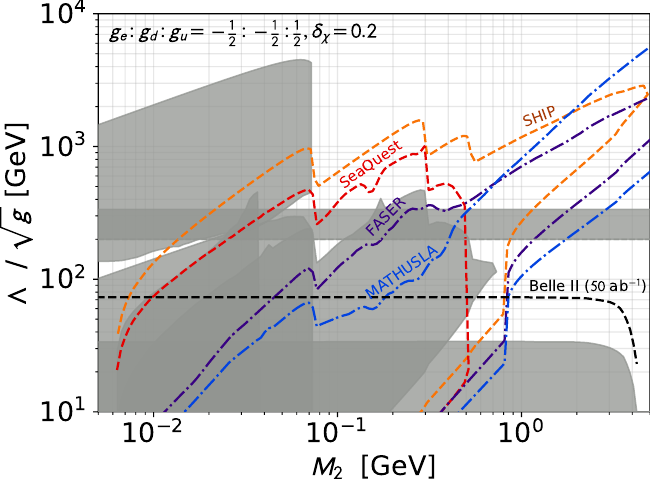
p g from future